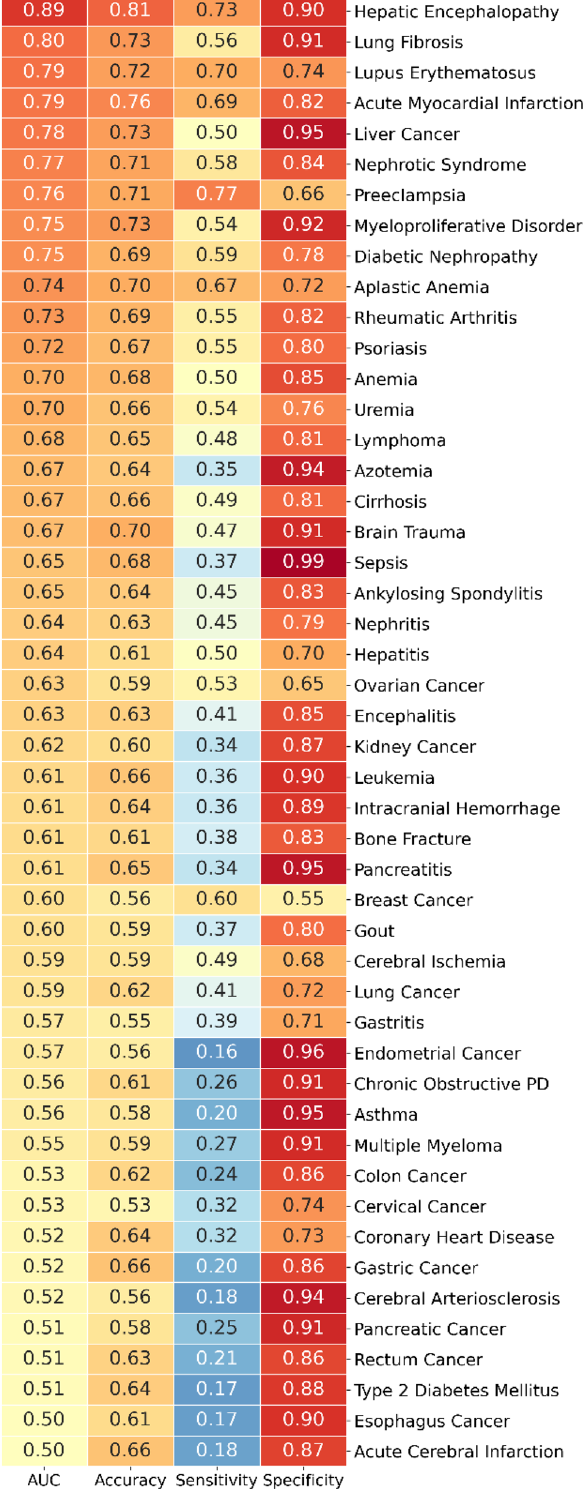
Figure 3. The AUC, accuracy, sensitivity, and specificity of serum LDH activities for 48 types of human diseases. Chronic obstructive PD chronic obstructive pulmonary disease, AUC area under the